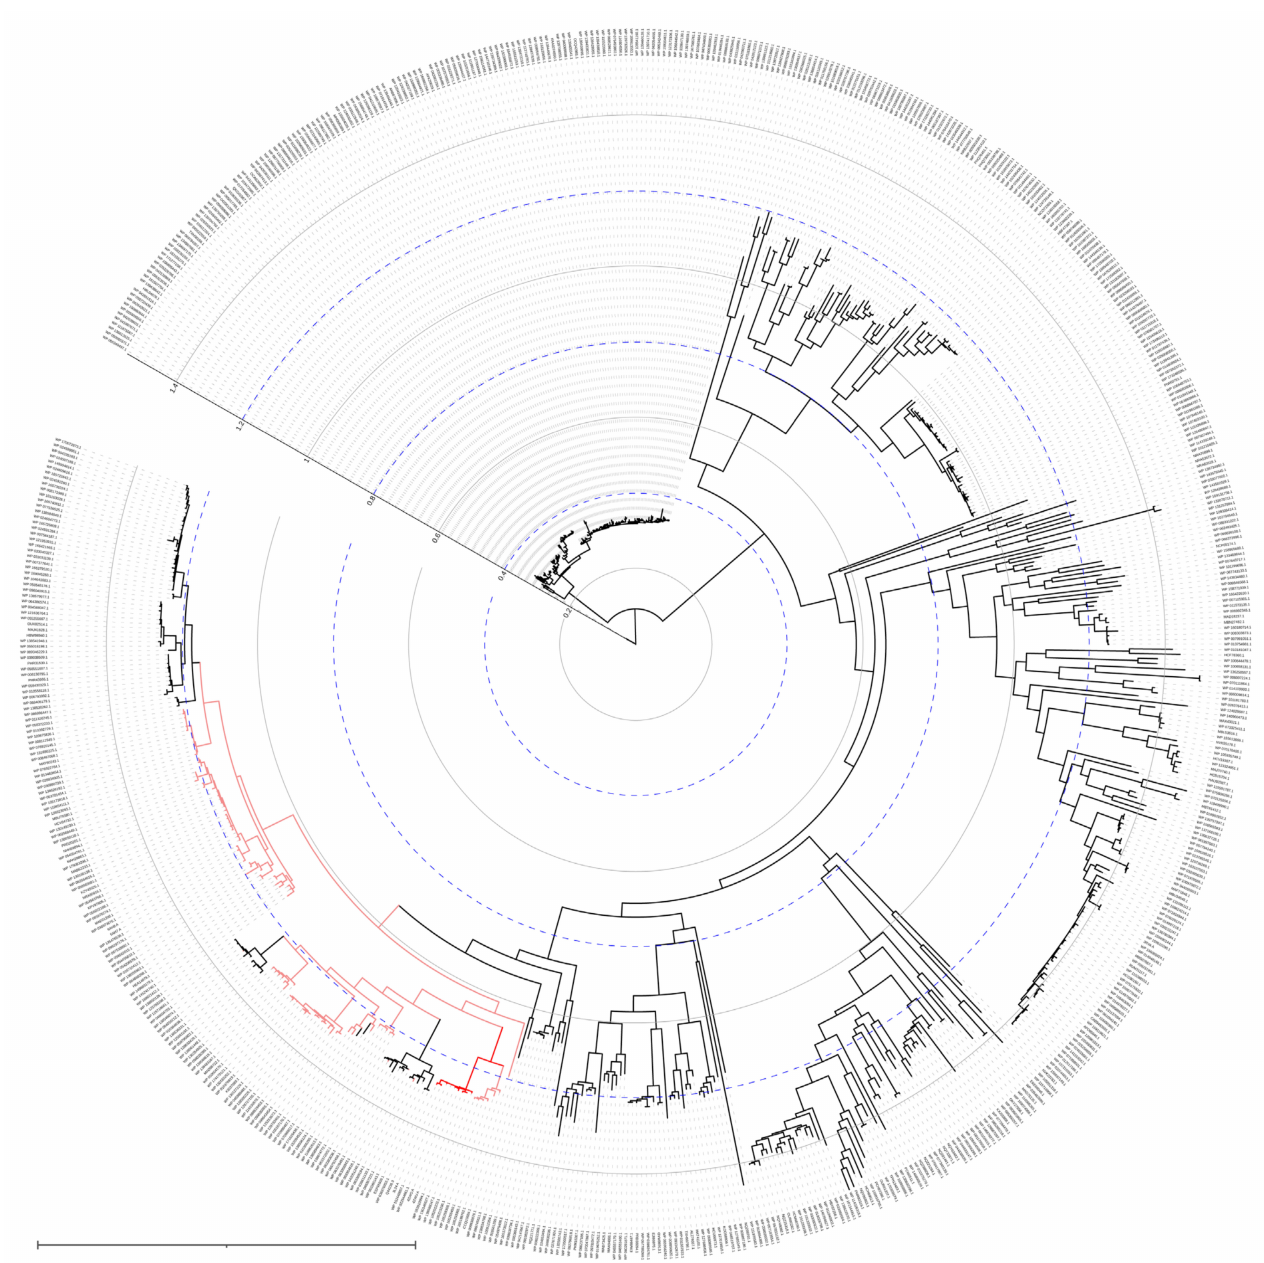
Figure 7. Phylogenetic tree of OPAA and its homologous enzymes (down to 56% identity). The tree was built as previously with PDB 3L24 as a reference sequence. Enzymes having high (90–100%) and good (80–89%) identity are highlighted with red and pink,